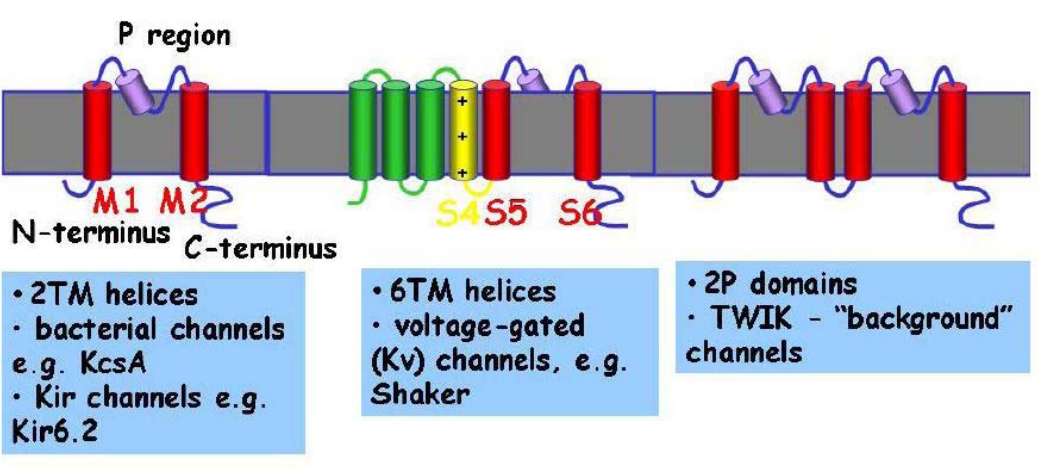
Fig. 1 Schematic diagrams showing the topology of one transmembrane (TM) subunit of each of the K + channel families. Left diagram represents the simplest core TM domain, made up of two TM helices (M1 and M2) plus a re-entrant pore loop containing a short pore helix plus an extended loop that contains the filter motif. Middle diagram represents topology of one subunit containing six TM helices. S5 and S6 correspond to M1 and M2 and S4 is the voltage sensor. Right diagram represents the TWIK and related channels, which contain two copies of the selectivity filter motif in one polypeptide chain. Therefore, two of these polypeptide chains are required to form the